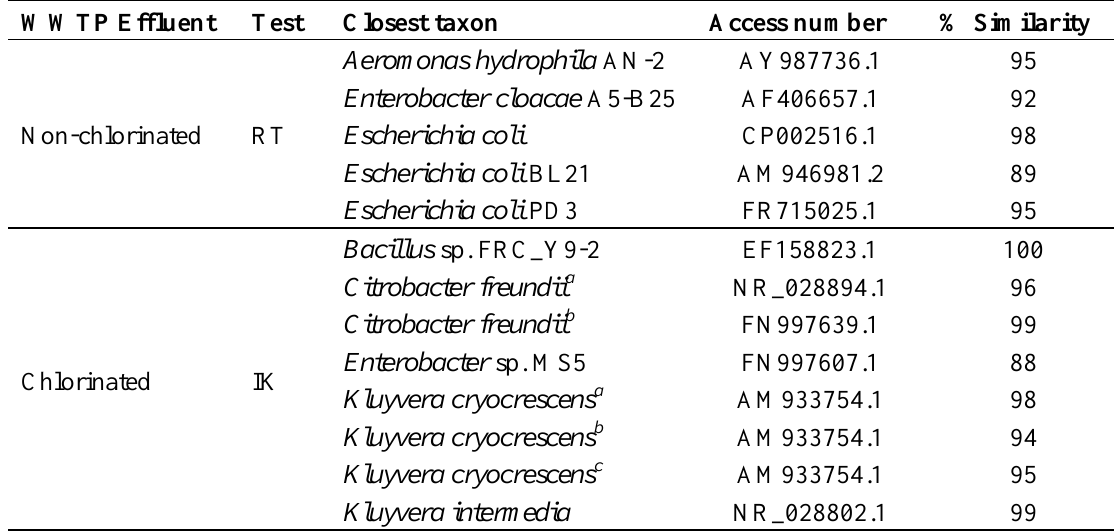
Table 1. Similarity of the isolated strains to the closest taxa identified in the GenBank